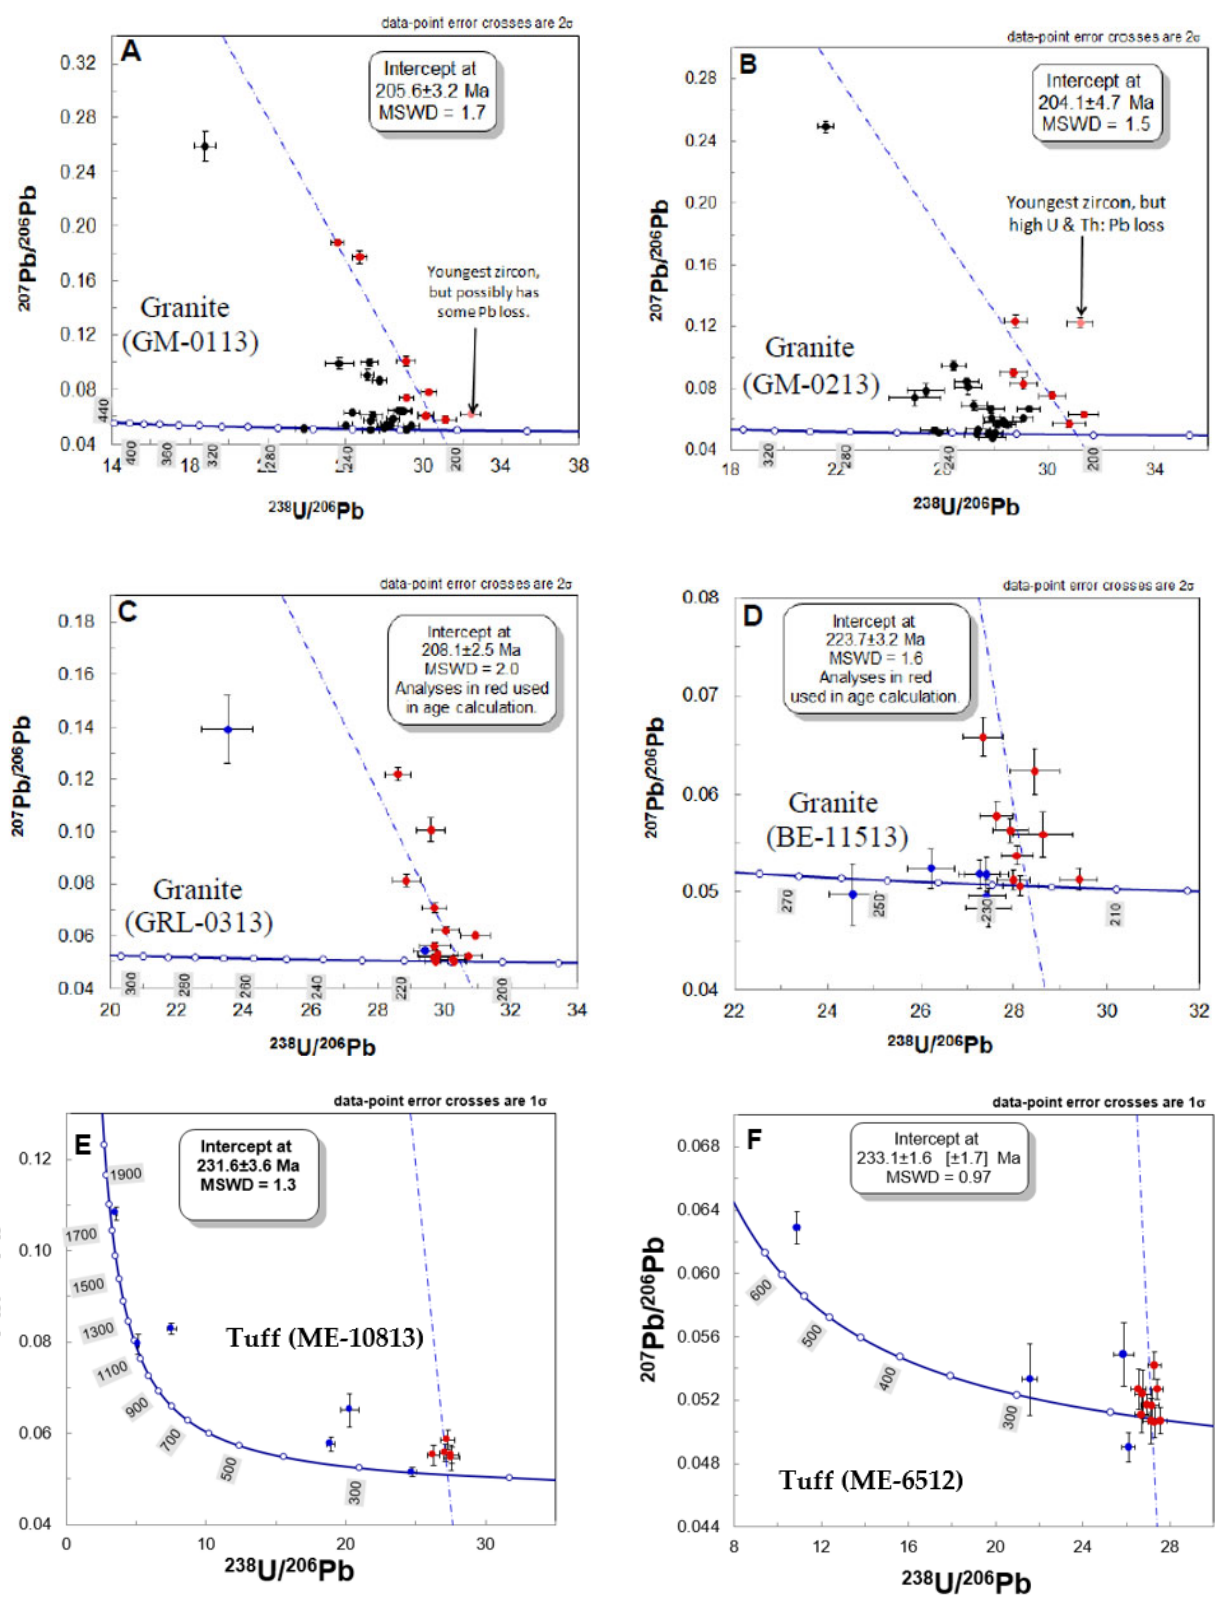
Figure 11. U-Pb dating of granite and tuff samples outcropping in the Central Belt. All the plots indicate the crystallization age of the granite. ( A ) U-Pb zircon dating of the Gua Musang granite in the vicinity of the Selinsing gold deposit. ( B ) U-Pb zircon dating of the Gua Musang granite in